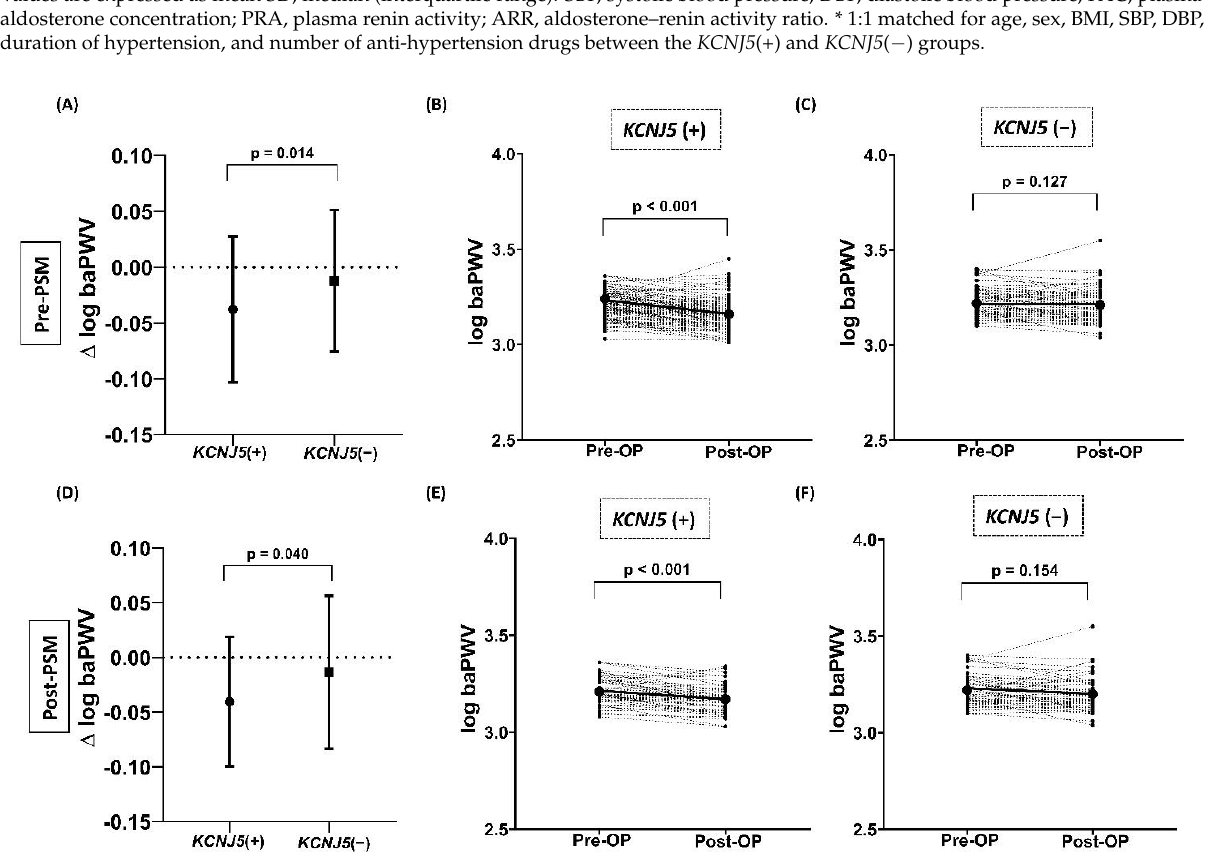
tomy, and Comparisons of Parameters 1 Year after Surgery between the APA Patients with and without Mutations Before PSM, both the APA patients with and without KCNJ5 mutations had signifi- cant decreases in SBP, DBP, number of hypertensive drugs, and log ARR, and both groups had significant increases in creatinine, potassium, and log PRA after adrenalectomy (Table 3). However, only the APA patients with KCNJ5 mutations had a significant decrease in log PAC ( p < 0.001) and log baPWV ( p < 0.001) after adrenalectomy, which was not found in the patients without KCNJ5 mutations (Figure 1B,C). In addition, the patients with KCNJ5 mutations had a significantly lower SBP ( p = 0.044), number of hypertensive drugs ( p = 0.010), and log baPWV ( p < 0.001) 1 year after adrenalectomy compared to those without mutations.